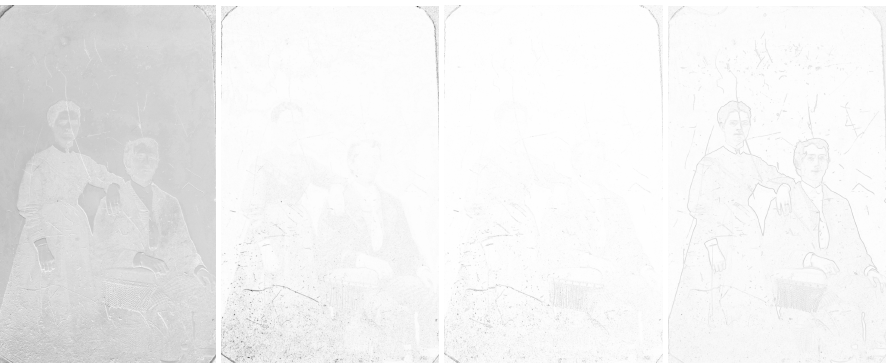
Figure 16. Difference images of tintype between LLa mode and LRFB reference mode. Left to right: difference image, SSIM map, ESSIM map, filtered edges of the image scanned in LLa